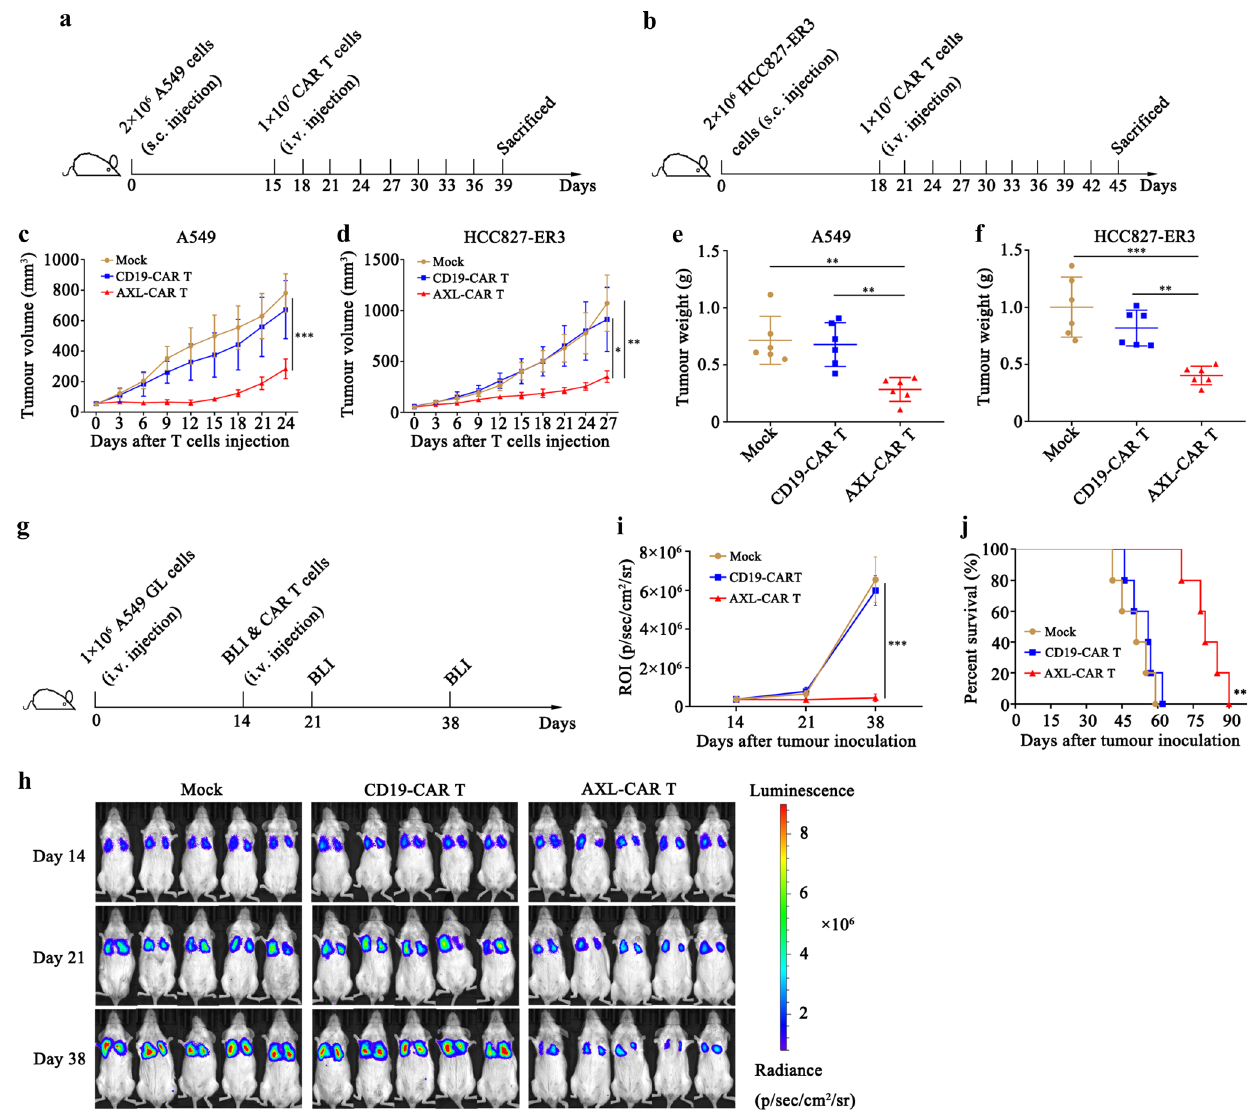
Fig. 2 | AXL-CAR T cells show moderate antitumour activity in subcutaneous and pulmonary metastasis mouse models. a , b Schemes of experiments with tumour-bearing mice. NSG mice received a subcutaneous injection of 2×10 6 A549 orHCC827-ER3cells.Whentumourvolumereachedabout50mm 3 ,1×10 7 AXL-CAR T cells or CD19-CAR T cells were injected through the tail vein and tumour volume wasmeasuredeverythreedays( n =6micepergroup). c , d Tumourvolumeinmice injected subcutaneously with A549 or HCC827-ER3 cells. ( c : Mock/CD19-CAR T vs AXL-CART p <0.0001. d :MockvsAXL-CART p =0.003,CD19-CARTvsAXL-CART p =0.02, two-way ANOVA with Tukey ’ s multiple comparisons test). e , f Tumour weight in mice injected subcutaneously with A549 or HCC827-ER3 cells at the end point. ( e : Mock vs AXL-CAR T p =0.002, CD19-CAR T vs AXL-CAR T p =0.004. f : Mock vs AXL-CAR T p <0.0001, CD19-CAR T vs AXL-CAR T p =0.004, one-way